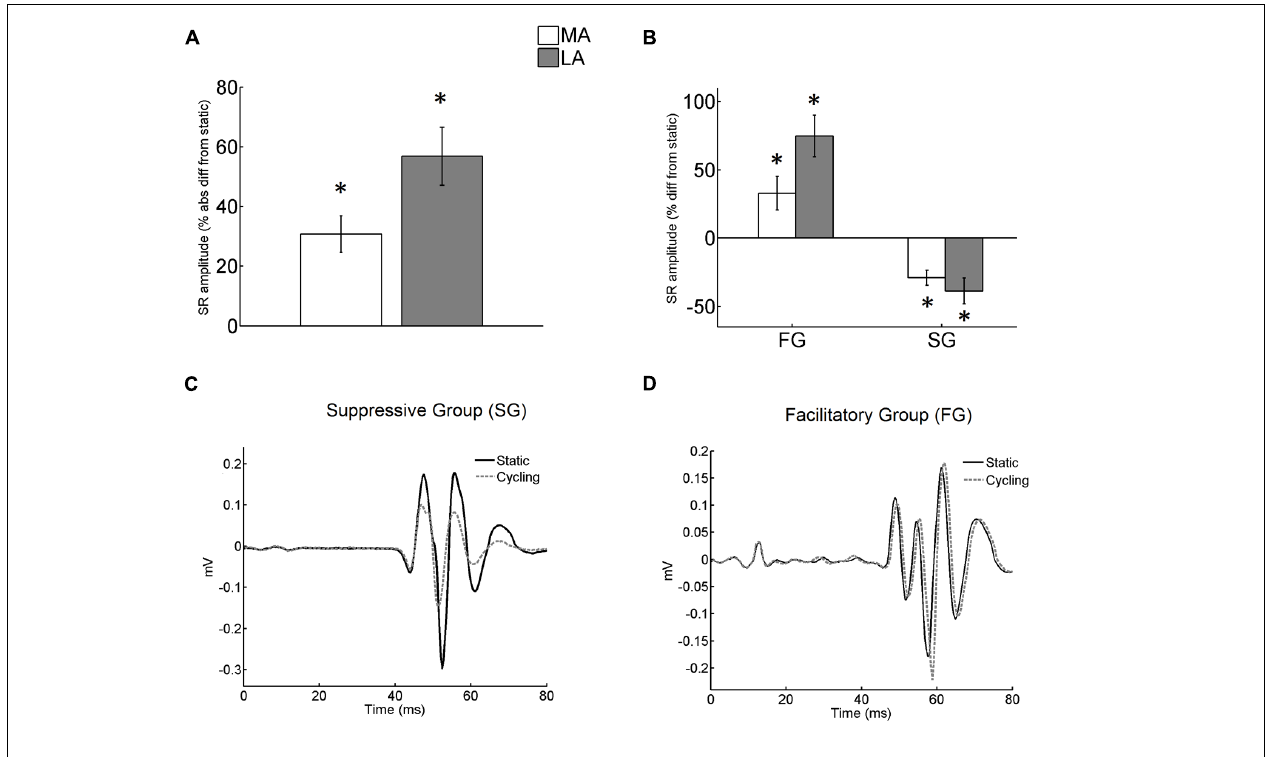
FIGURE 2 | (A) Absolute difference (in %) of the stretch reflex (SR) conditioned by arm cycling from SR in static condition. The difference from static was significant for both legs (asterisks mean p < 0.001). No significant difference of arm cycling effect was detected between legs; (B) difference of conditioned SR from static (in %) for both FG and SG groups. The difference from static was significant for both legs and both groups (asterisks mean p < 0.001 and p < 0.003 for FG and SG, respectively). However the effect of arm cycling between legs was not different for both